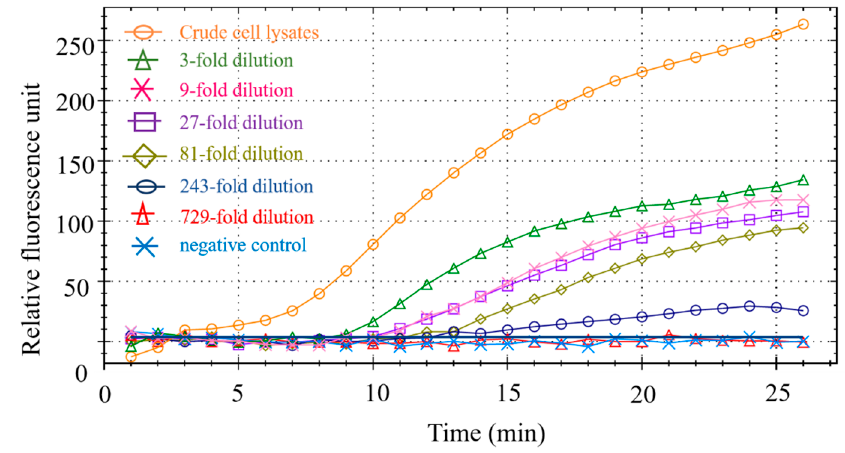
Figure 7. RPA sensitivity.